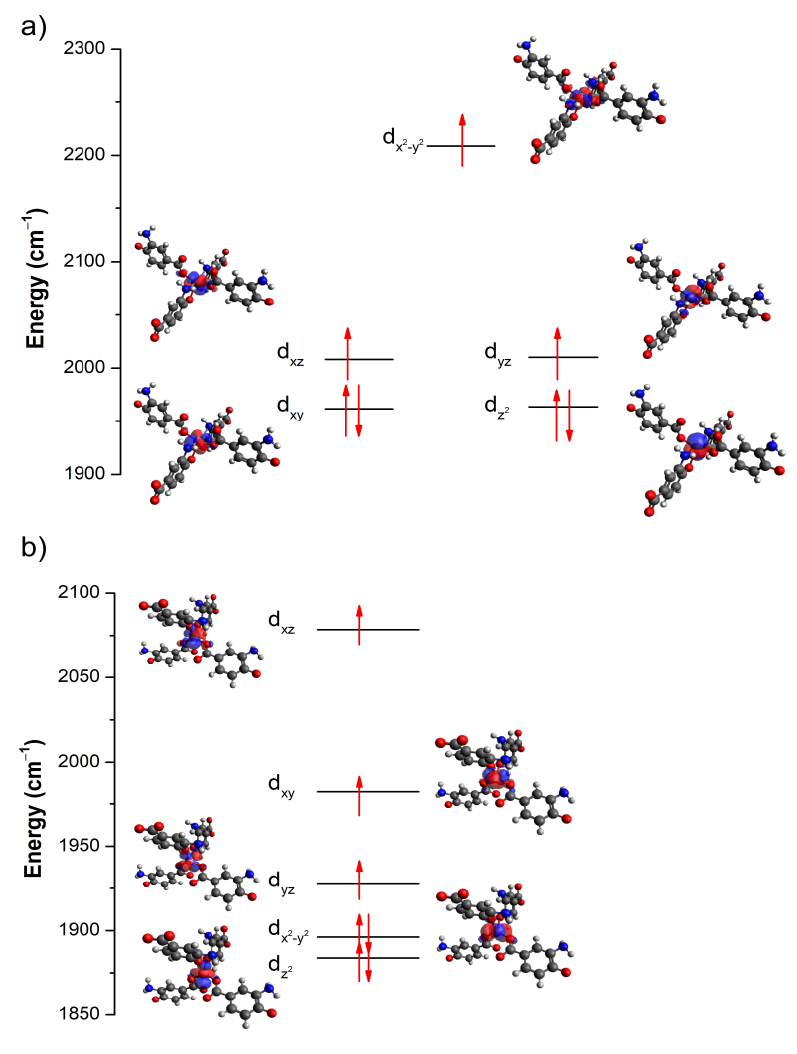
Figure 4. AILFT computed d-orbital splitting representation of the distorted ( a ) TPR and ( b ) Td coordination environments.